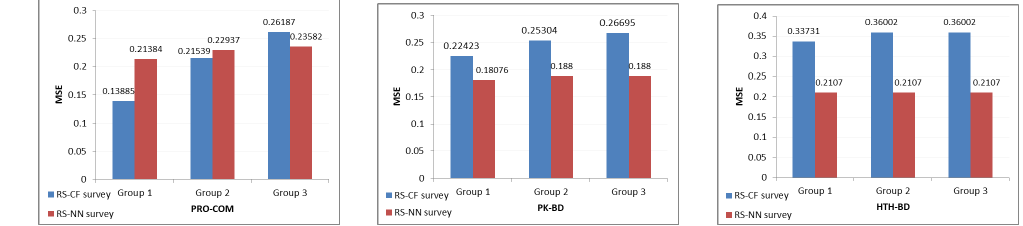
Figure 8. The MSE of three